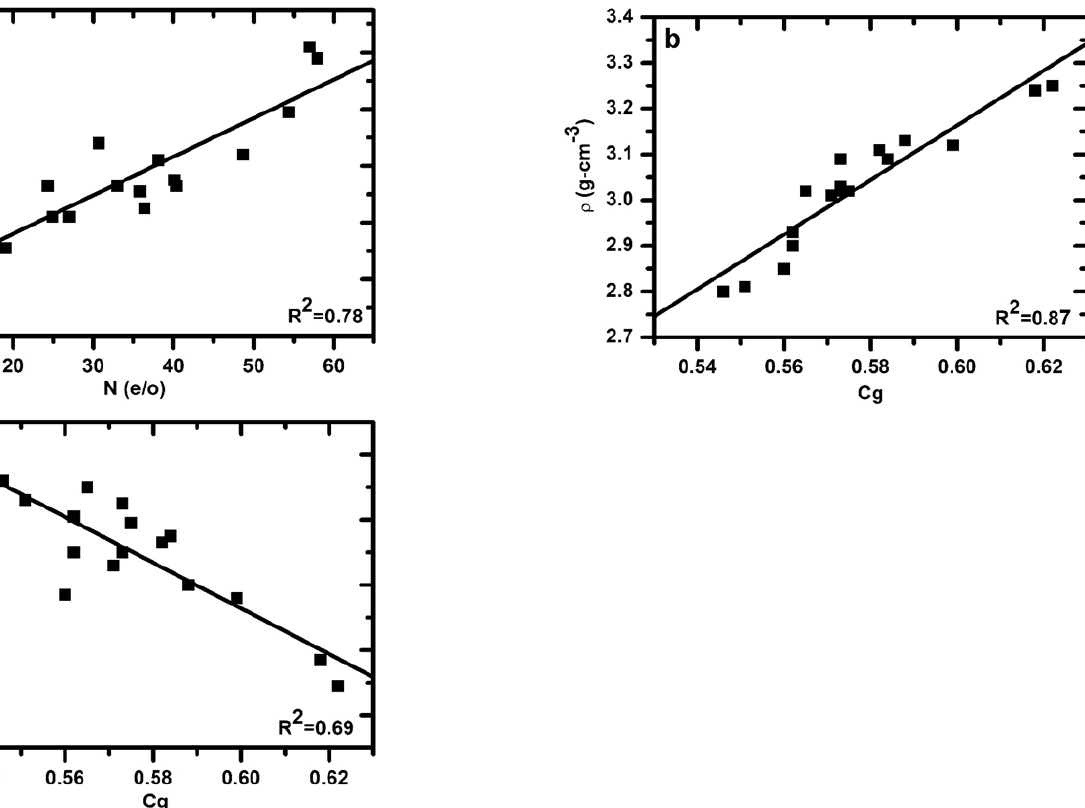
Figure 4. ( a ) Microhardness as a function of glass atomic packing density ( b ) microhardness as a function of nitrogen content (in e/o). 3.6. Effect of Atomic Packing Density on Refractive Index The RI depends primarily on the polarizability of the various constituent ions of ma- terials and the bonds between atoms. Figure 5a show that there is a substantial increase in RI with the increasing atomic packing density of the glasses. Figure 5b show the relation- ship between the RI and N content. A fit of the obtained data to a linear dependence of RI on 𝐶 𝑔 yielded RI = -0.92 (0.25) + 4.62(0.43) × [ C g ], with R 2 = 0.87 and the dependence of RI on N content yielded RI = 1.49 (0.02) + 0.0072 (0.0005) × [N], with R 2 = 0.91, indicating that the 𝐶 𝑔 and N content have a similar effect on the RI . The strong relationship between the density and RI of Ca – Si – O – N is expected when considering the result of Figure 5c and their corresponding correlation coefficient with R 2 = 0.77. Indeed, the refractive index of an oxide-based glass is normally governed by both the atom/ion polarizabilities and the packing density of the constituent atom.